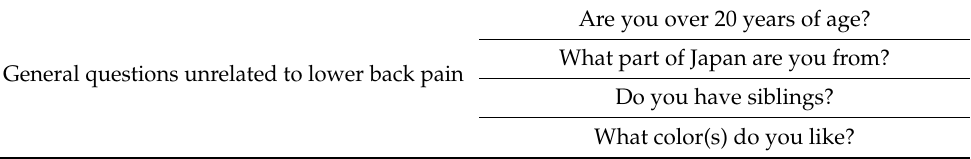
Table 1. Questions for study subjects.